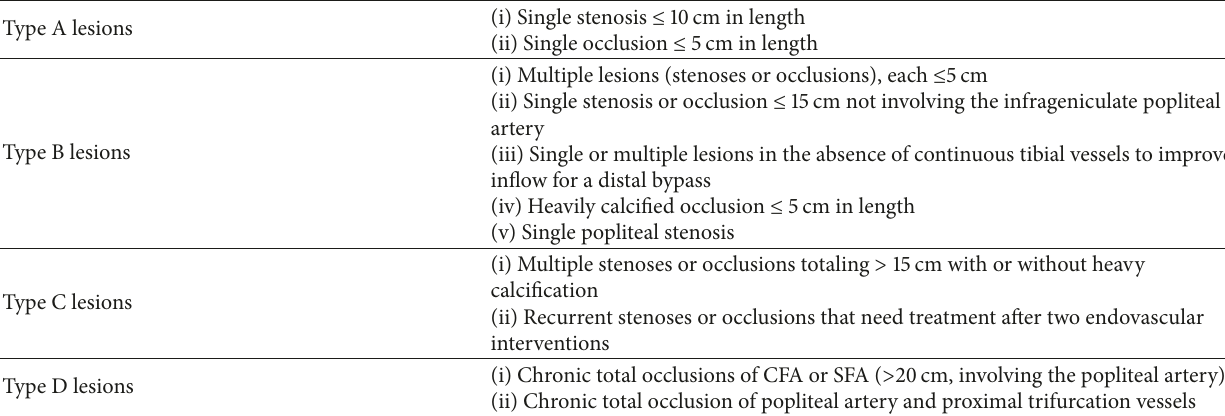
Table 1: TASC classification of the aortic and iliac lesions [permission to reproduce the image obtained from Elsevier through Rightslink